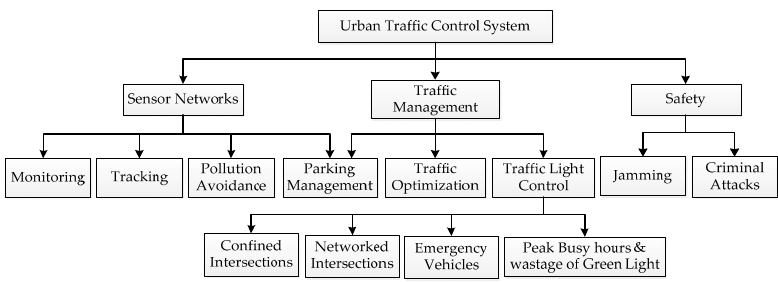
Figure 5. Hierarchical functionality of WSN based urban traffic management system.